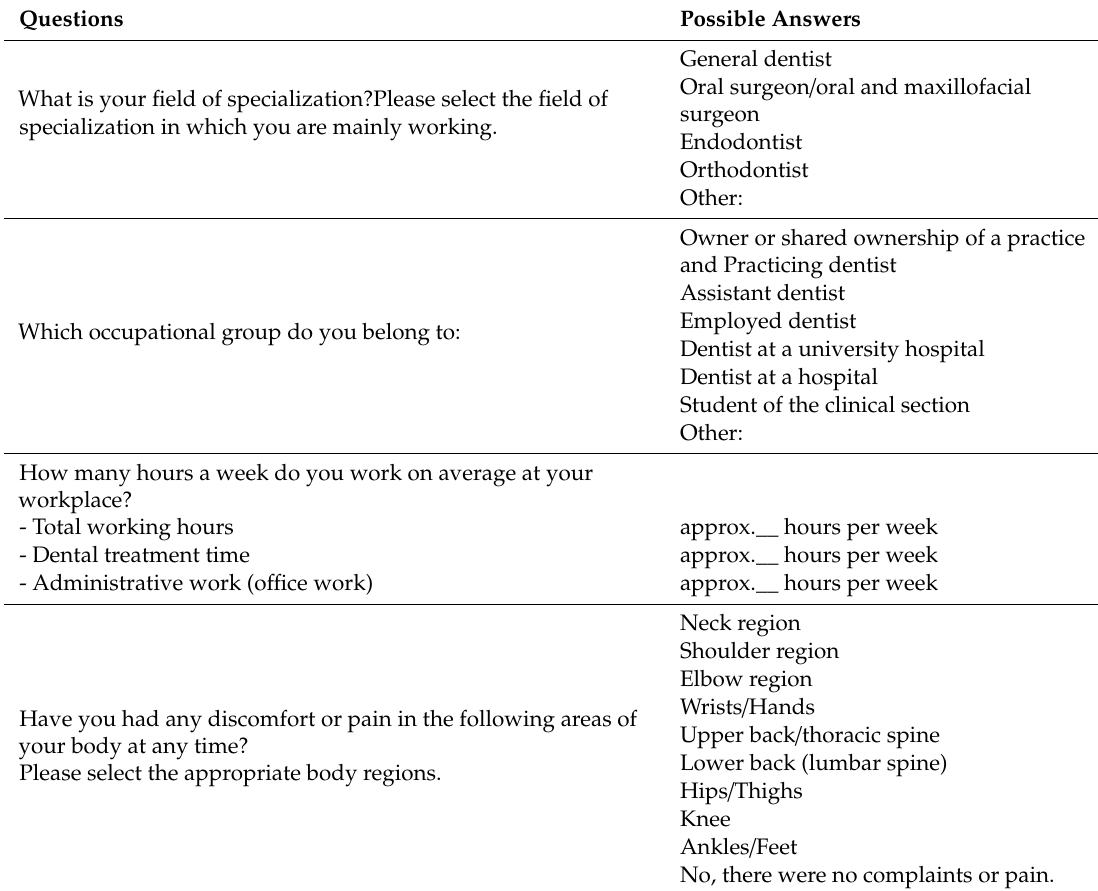
Table 1. Exemplary questions from the